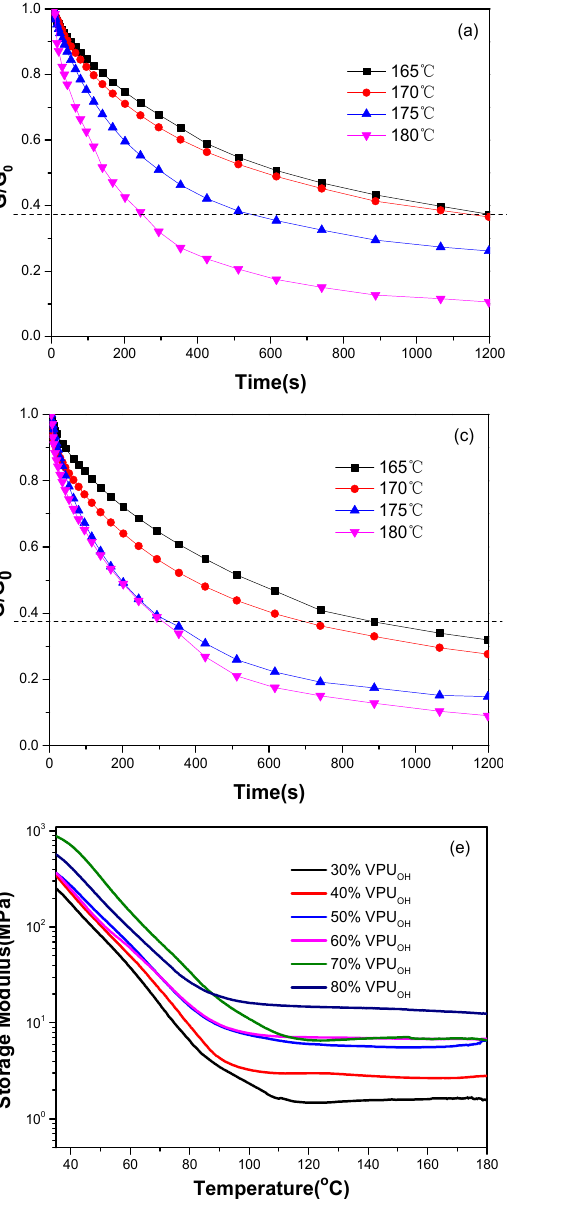
Figure 5. ( a ) Stress relaxation study of 40%VPU OH , ( b ) Arrhenius plot with linear fit for 40%VPU OH , ( c ) Stress relaxation study of 70%VPU OH , ( d ) Arrhenius plot with linear fit for 70%VPU OH , ( e ) Storage module curves, and ( f ) Tan δ curves of the VPU OH series with different HDI content.